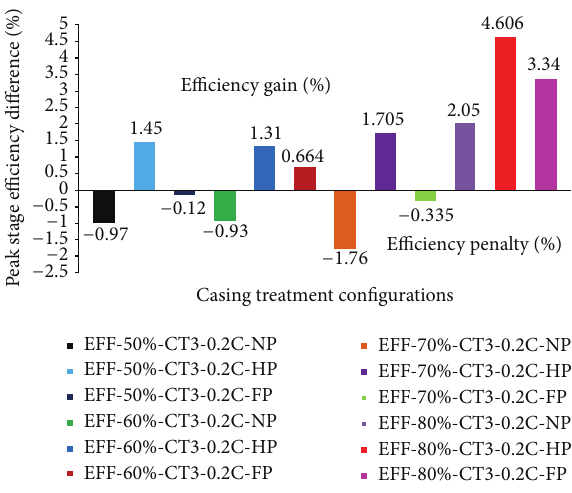
Figure 6: Gain and loss in peak stage efficiency with casing treat- ment-plenum chamber configurations at 20% axial